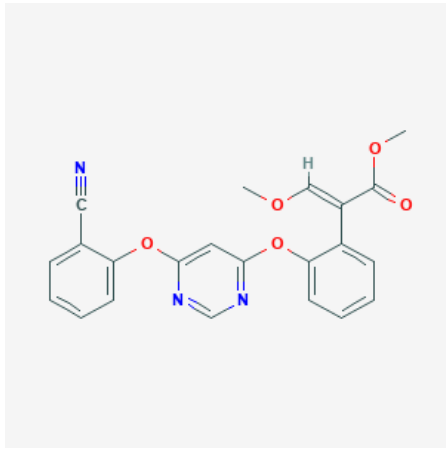
Fig. 1. Chemical structure of